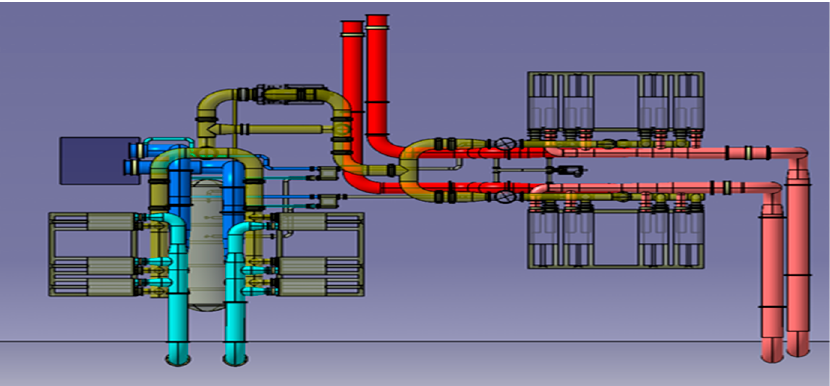
Figure 2. Concept design of a 1 MW floating ocean thermal energy conversion (OTEC) in Korea.